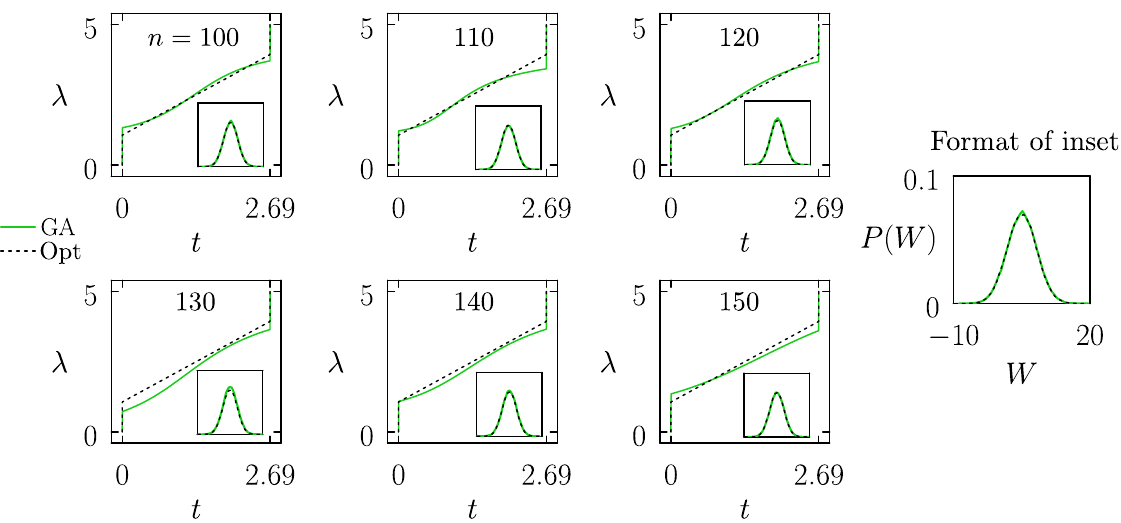
position.FIG. 4. Supplement to Fig. 2. (a) As in Fig. 2(d) but with results for five additional generations. The shape of the learned protocol fluctuates around the optimal one, but all are similarly